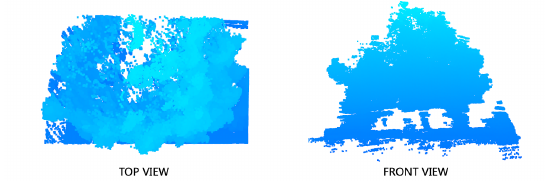
Figure 12. Wrong Split Results. The Segmented tree has the messy ground plane.